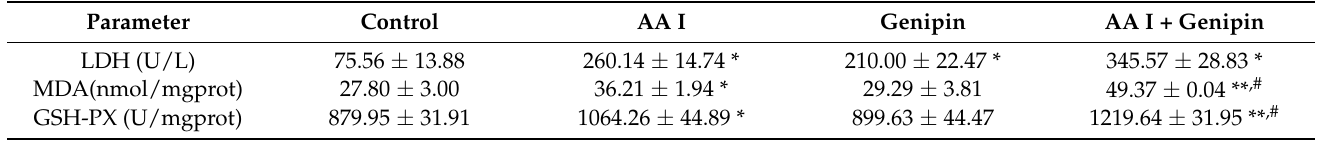
Table 1. Values of LDH activity, MDA activity and GSH-Px activity.